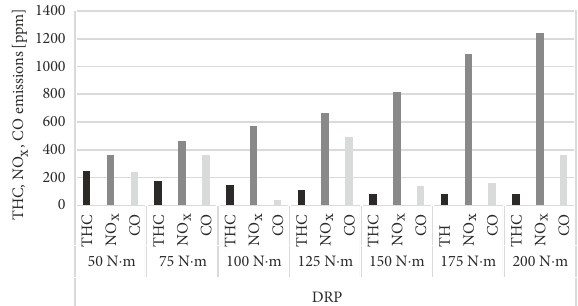
Figure 16. Emission of THC, NO x and CO for DRP sample with operating parameters of engine 1500 rpm